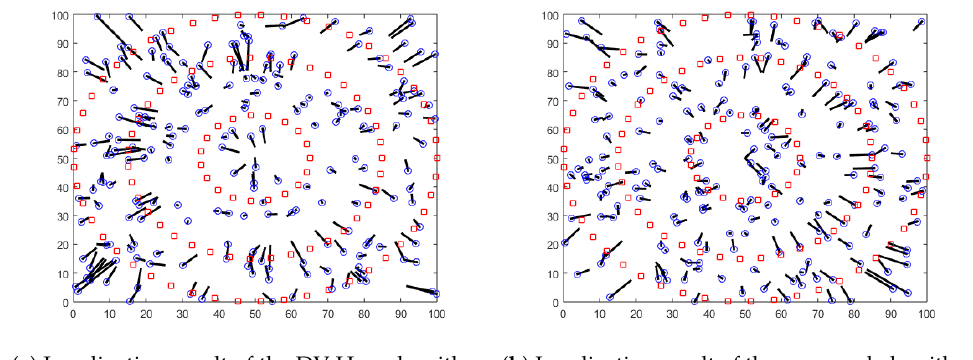
Figure 6. Localization results with circular deployment of